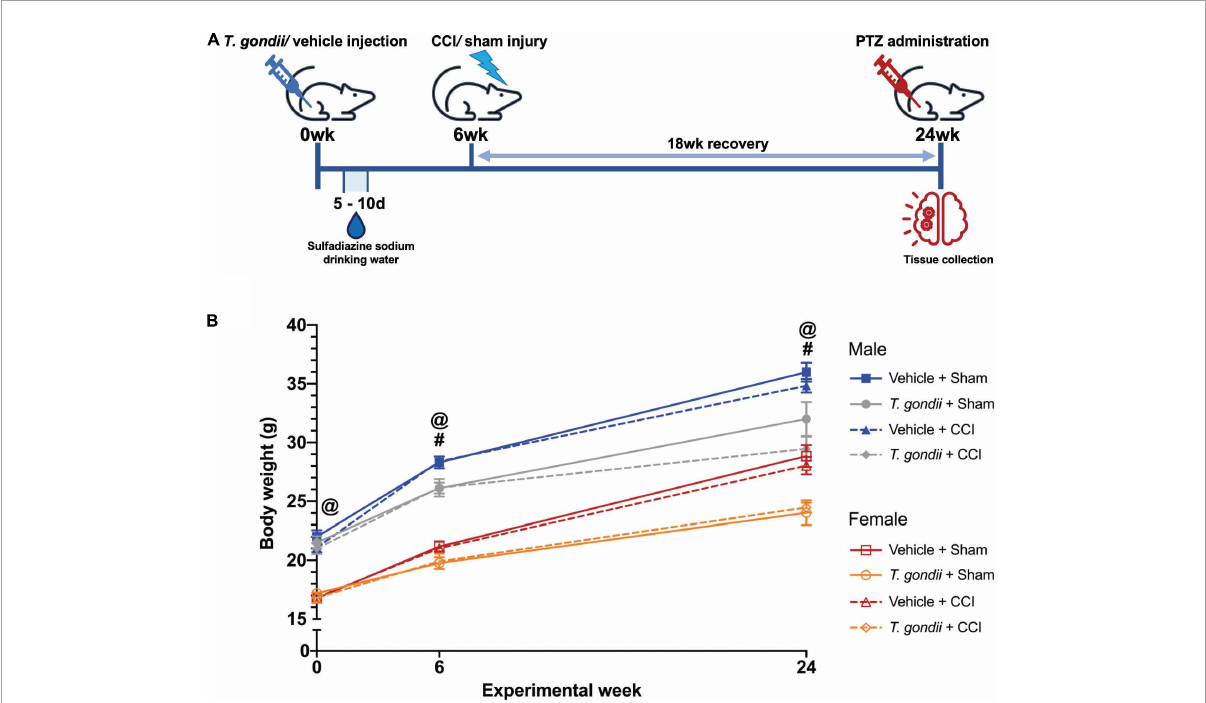
FIGURE1 Study timeline. (A) All mice were injected with either Toxoplasma gondii or vehicle only. Six-weeks were allowed to pass to establish a chronic infection. At this point, mice received either a controlled cortical impact (CCI) or sham injury. After an 18-week recovery (i.e., at 24-weeks from the initial T. gondii or vehicle injection), mice underwent pentylenetetrazol (PTZ) administration for assessment of seizure susceptibility immediately prior to euthanasia and tissue collection. (B) Body weight significantly differed between male and female mice throughout the study, with males weighing more than females. By 6-weeks post-injection, T. gondii mice weighed significantly less than vehicle groups, and this difference was sustained until PTZ administration/endpoint. # T. gondii -infected mice significantly differ from vehicle mice, @ female mice significantly differ from male mice, p < 0.05. n = 10–12/group/sex. Data shown is mean ±